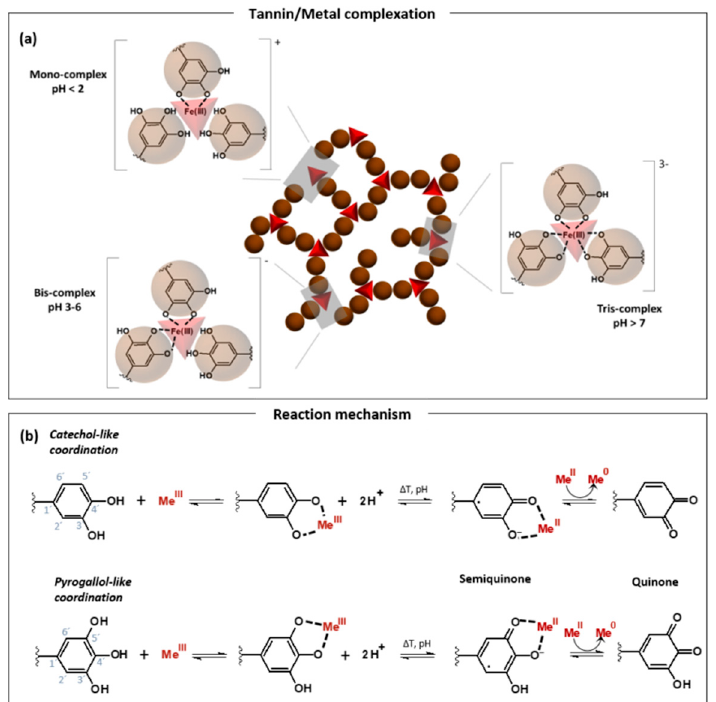
Figure 2. Metal complexation and reduction behavior and involved mechanisms. ( a ) Schematic representation of the formation of a metal–phenolic network between tannin and iron ions where, depending on the pH value, a mono-, bis- or tris-complex is formed, and the network formation capability is accordingly changed. ( b ) General reaction mechanisms for the complexation of metal ions and the subsequent ligand to metal electron transfer that enables tannins to reduce metal ions to elemental metal. The reduction progresses from the fully reduced forms through a semiquinoid form with one carbonyl to a quinoid form with two carbonyl groups.